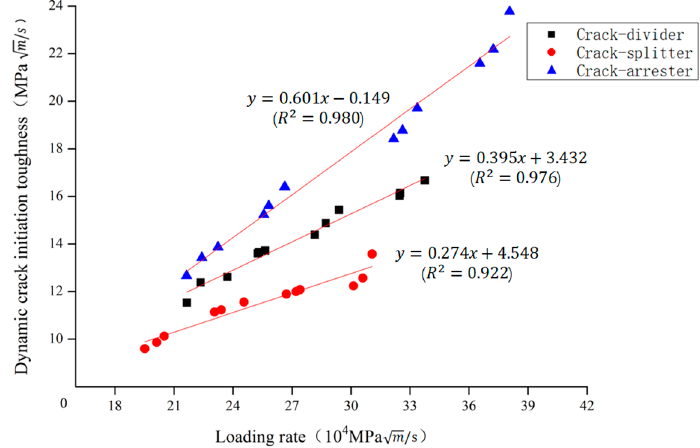
Figure 5. Relationships between dynamic crack initiation toughness of shale and loading rate under different loading configurations.